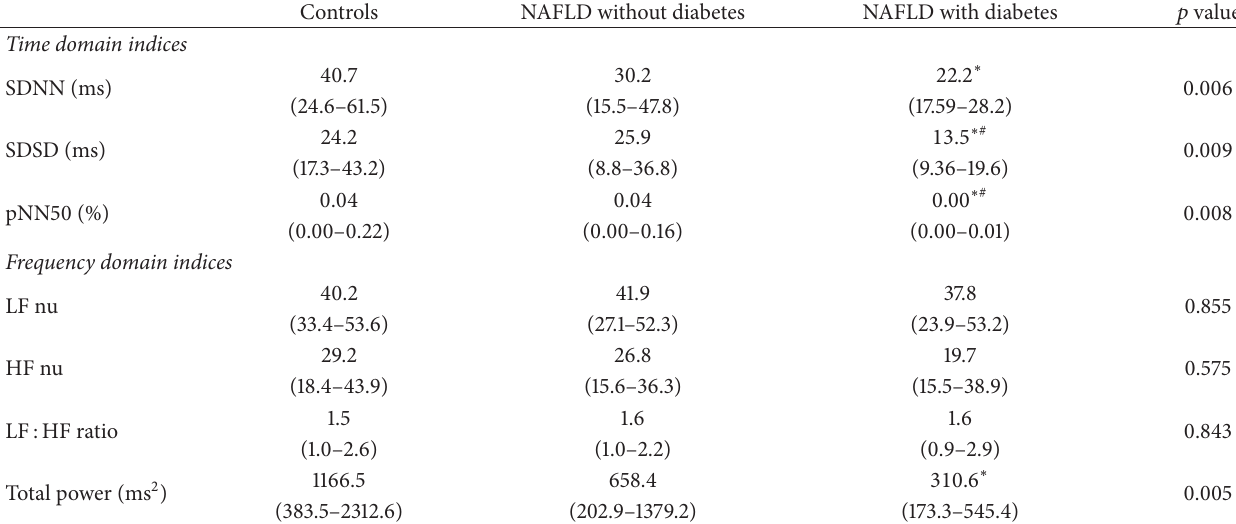
Table 2: Time domain and frequency domain indices of HRV in the study population.